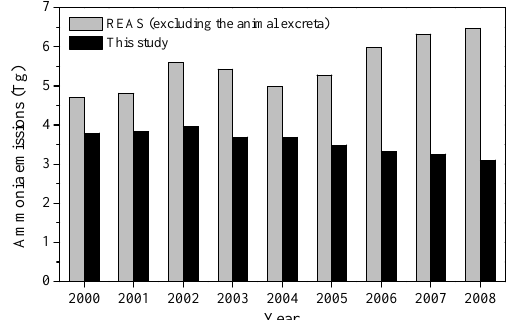
Figure 7. Comparison of total NH 3 emissions between this study and REAS.